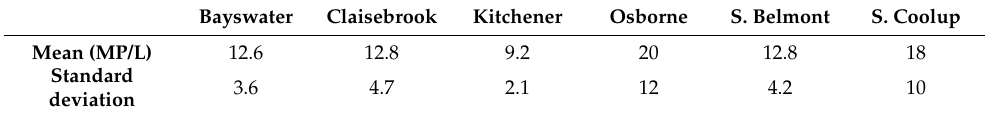
Table 3. Mean microplastic concentration (MP/L) and standard deviation at a catchment level.